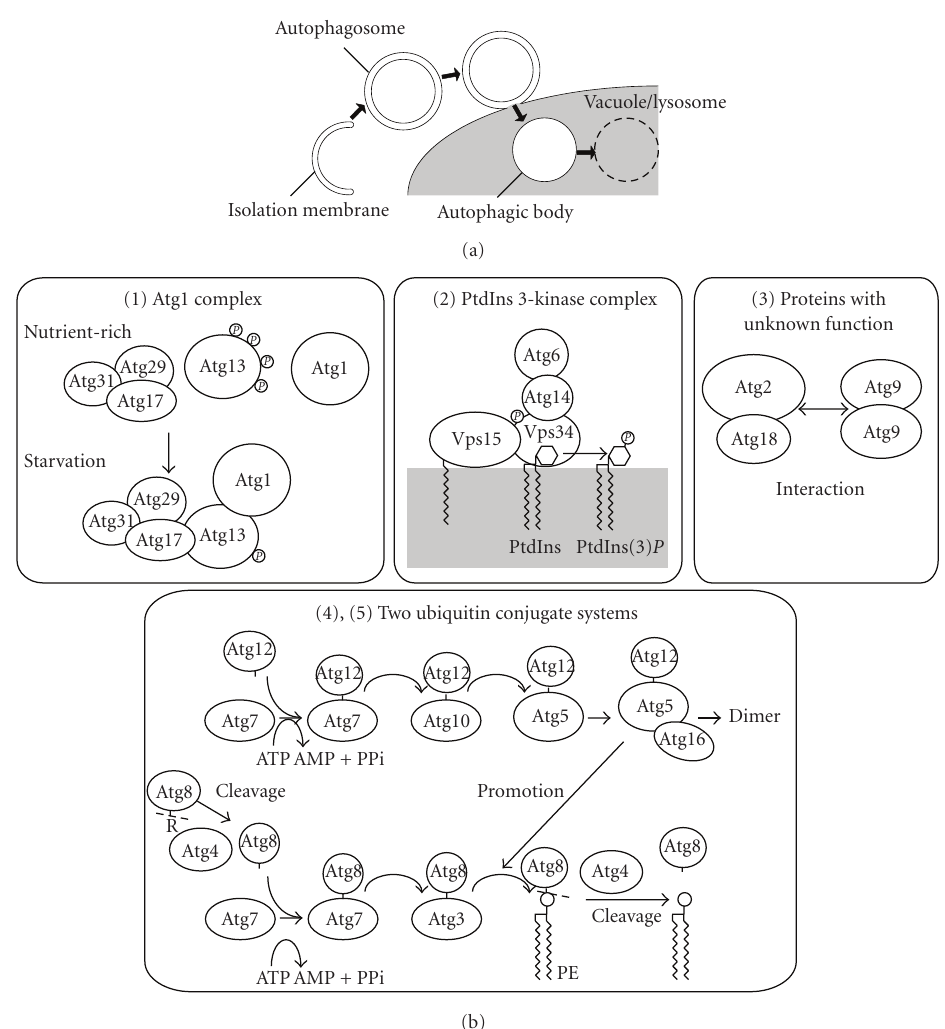
Figure 1: Membrane dynamics of autophagy and 5 groups of Atg proteins that are essential for autophagosome formation. (a) A schematic diagram of the membrane dynamics during autophagy. Upon autophagy induction, the isolation membrane elongates to enclose a portion of the cytoplasm, and the ends of the isolation membrane fuse to generate a closed double-membrane structure, the autophagosome. The outer membrane of the autophagosome fuses with the vacuole/lysosome to release the inner membrane structure, the autophagic body, into the lumen where the autophagic body and the enclosed cargo are degraded for recycling. (b) Five groups of Atg proteins are essential for autophagosome formation. Currently, 18 Atg proteins are thought to be essential for autophagosome formation. Based on their functions, they are classified into 5 groups. Reproduced with modification from